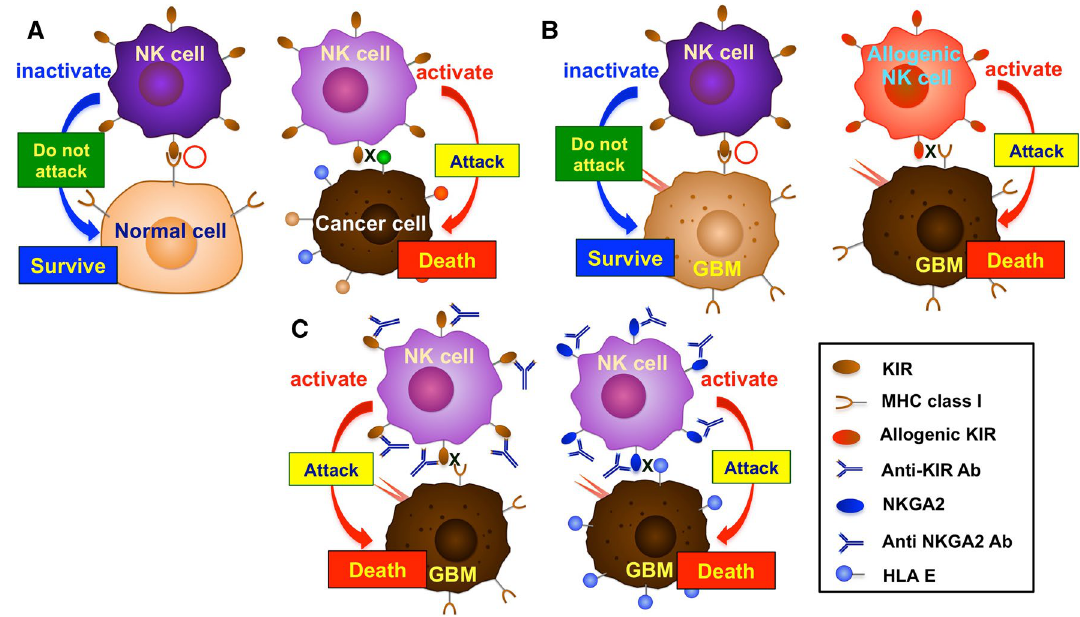
Fig. 3 Killer cell immunoglobulin-like receptors (KIR) in NK cells. A Normal cells express major histocompatibility complex (MHC) class I mol- ecules such as human leukocyte antigen class I. This binds to KIR, which is expressed on the surface of NK cells. When KIR binds to MHC class I molecules, NK cells recognize cells as autologous, and NK cells are inactivated. Most cancer cells do not express enough HMC class I mol- ecules. Therefore, NK cells can not recognize these cancer cells as autologous cells and attack them. B GBM cells express a sufficient amount of MHC class I molecules and are not attacked by NK cells, like normal cells. When allogeneic NK cells were used, they attack GBM because allogeneic NK cells can not recognize GBM cells as autologous cells. C Anti-KIR antibody treatment allows KIR to attack GBM because KIR cannot bind to MHC class I molecules. Similarly, Natural killer group 2, member A (NKGA2) antibody treatment leads to activated NK cells. This is because NKGA2 on NK cells cannot bind to HLA-E on GBM, and inhibitory signals do not